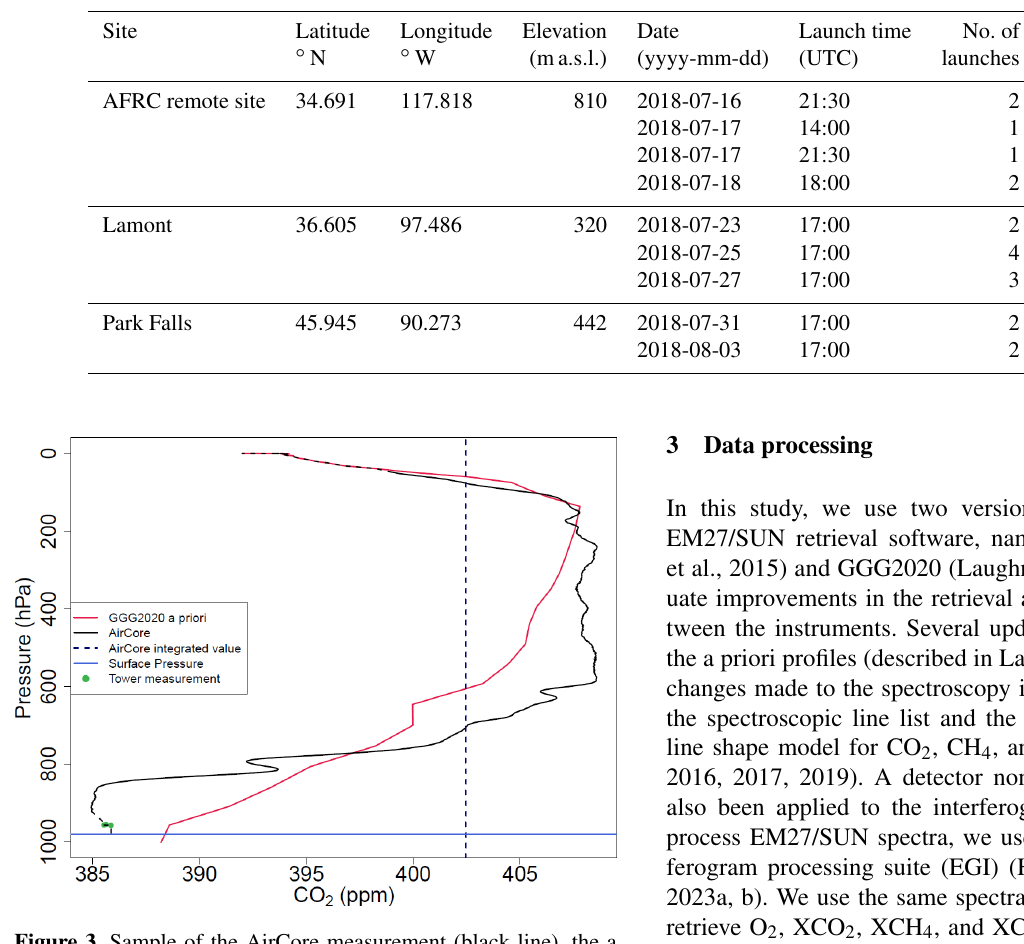
Figure 3. Sample of the AirCore measurement (black line), the a priori profile used by GGG2020 (red line), in situ tower measure- ments (green dots), and surface pressure measured by the ground- based sensor (horizontal blue line) at Lamont on 25 July 2018. The dashed black line shows the portion of the AirCore profile that was extrapolated, using the GGG2020 a priori profile above the AirCore ceiling altitude, or interpolated, using the tower measurements be- low the profile. The navy dashed blue vertical line depicts the aver- age calculated column value using